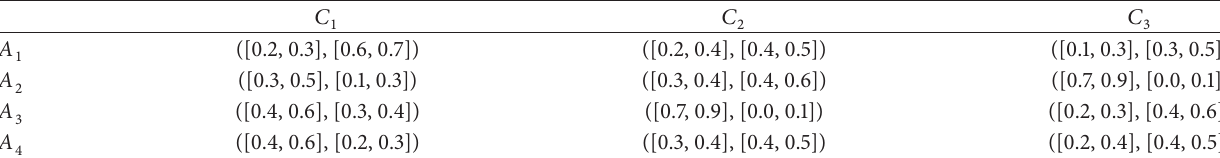
Table 1: The interval-valued intuitionistic fuzzy decision matrix 𝐵 .